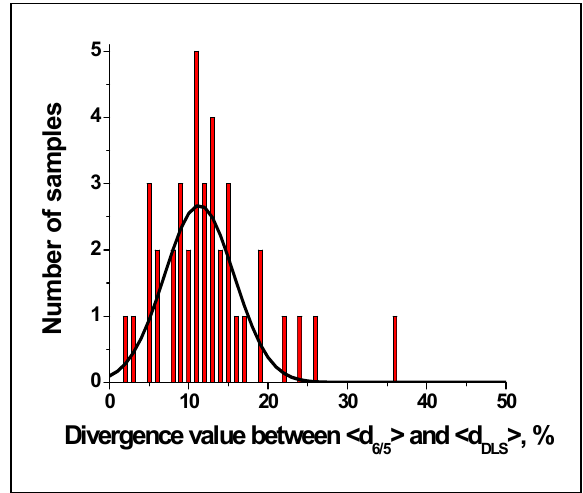
Figure 8. Divergence values between TEM data (< d 6/5 >) for initial catalysts and DLS data (< d DLS >) prepared from sols (total quantity of samples is equal 39). Experimental data have been fitted by the Gauss distribution function (black line).